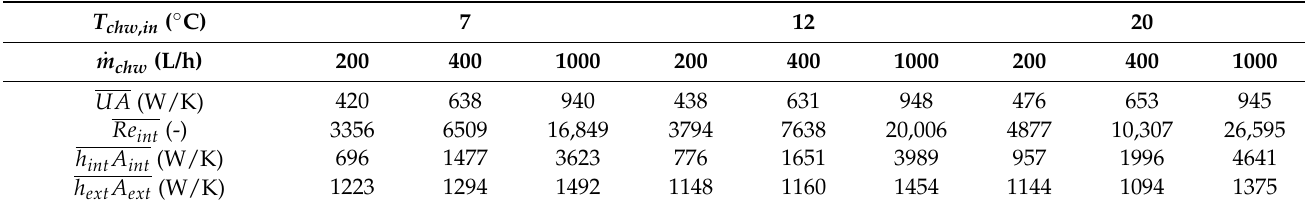
Table 5. Evaporation heat transfer conductance average plateau values.